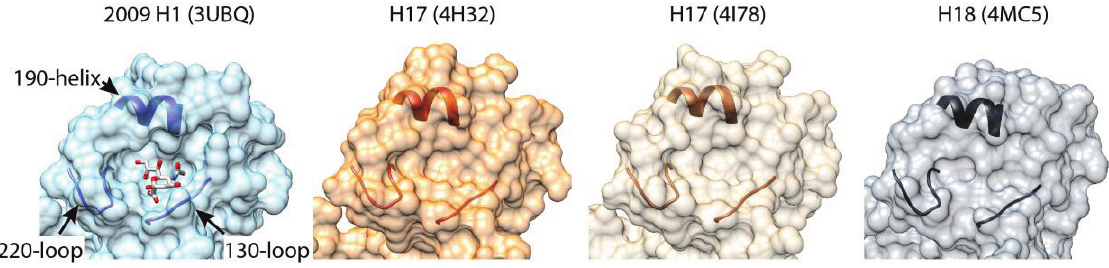
Figure 1. Altered receptor-binding sites in H17 and H18 HA. A binding cavity defined by the 130-loop, the 220-loop and the 190-helix is occupied by sialic acid in 2009 H1 HA [56]. Polymorphisms surrounding the binding cavity and the absence of conserved binding-site residues dramatically flatten the binding pocket in structures of H17 and H18. H17 and H18 fail to bind canonical sialic acid receptors (see text for